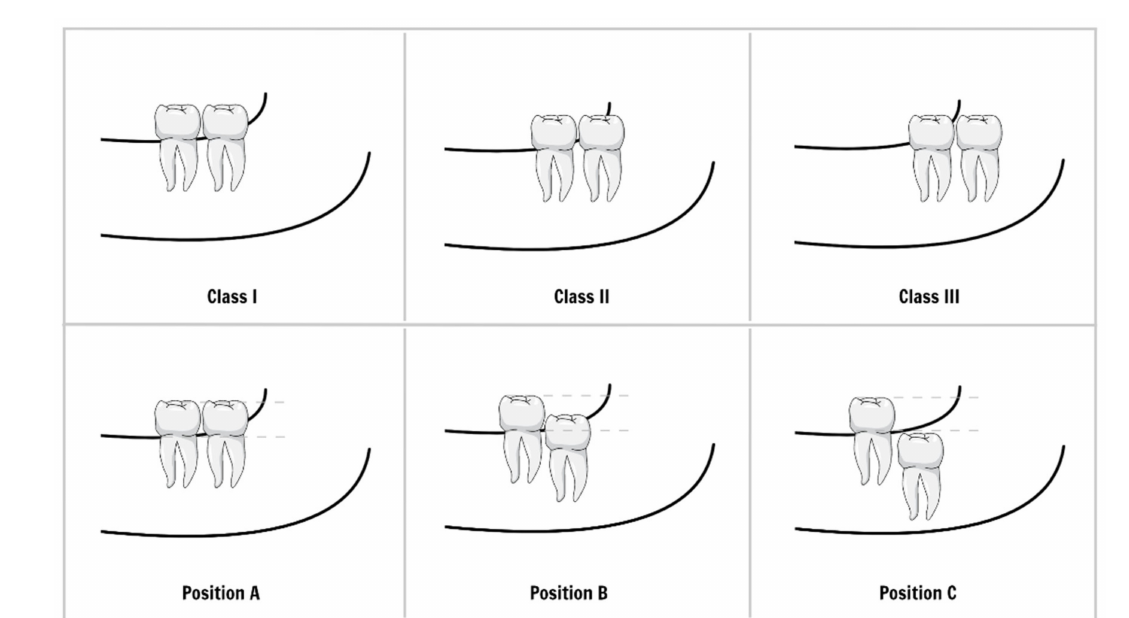
Figure 2. Pell and Gregory classification. The classes are based on the relationship between the lower wisdom tooth (third molar) and the mandible ramus. The positions are based on the vertical relationship between the second and third molars.